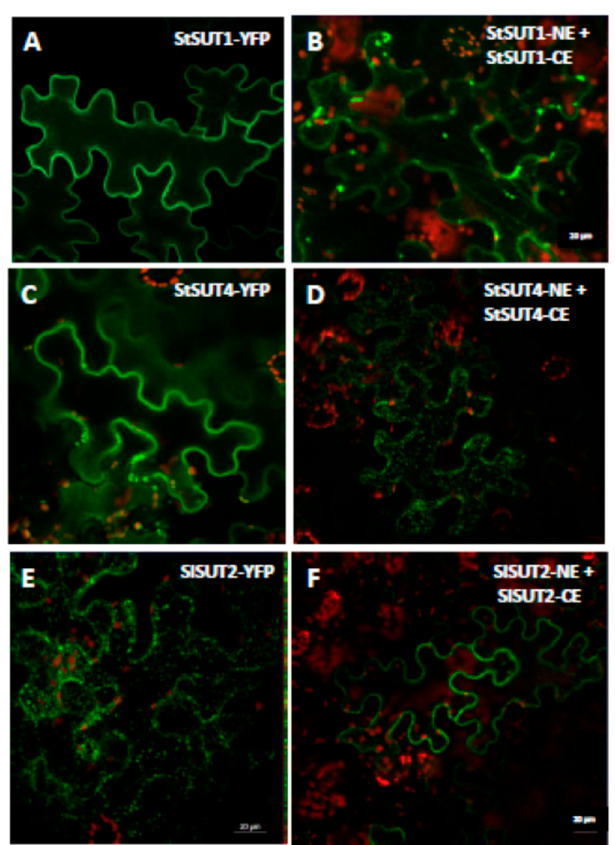
Figure 1. Homodimerization of sucrose transporters affects subcellular targeting. A. StSUT1 in pK7GW2.0 (YFP) transiently expressed in N. benthamiana leaves. B. BiFC experiment showing StSUT1 homodimerization were used as a positive control. C. StSUT4 in pK7GW2.0 (YFP). D. BiFC experiment showing StSUT4 homodimerization. E. SlSUT2-YFP expression in N. benthamiana leaves. F. BiFC experiment showing SlSUT2 homodimerization. For BiFC experiments sucrose transporter cDNAs were cloned in VYNE and VYCE vectors [13] and co-infiltrated together with the viral p19 repressor. All pictures were taken 4 d after infiltration.